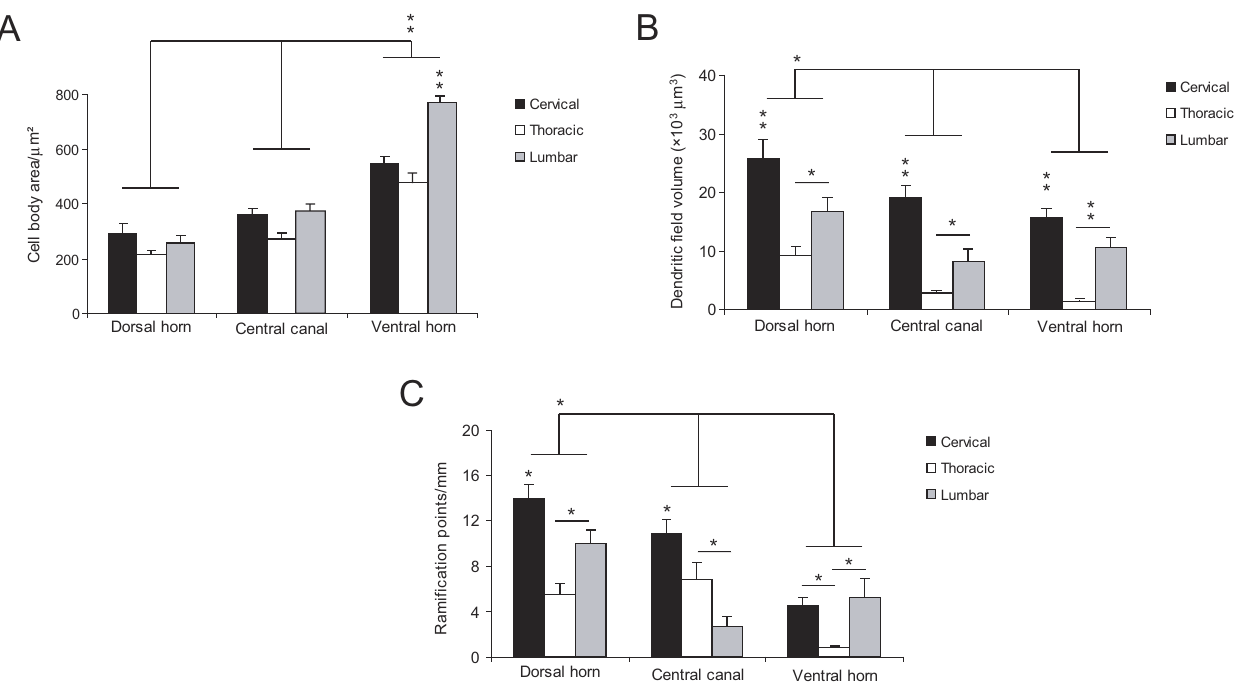
Figure 6. Comparative morphometry of spinal cord’s NADPH-d neurons. Cells located in the ventral horn have the largest cell bodies, especially in lumbar segments (A) . Conversely, cells found in the dorsal horn (especially in both cervical and lumbar segments) possess a larger dendritic coverage (B) . In addition, neurons found in the dorsal horn of the cervical and lumbar segments have a greater number of branch points than cells found in the same region of the thoracic segment (C) Asterisks in horizontal bars indicate statistically signifi cant comparisons ( *p < 0.05, **p < 0.01, ANOVA/Newman–Keuls post hoc